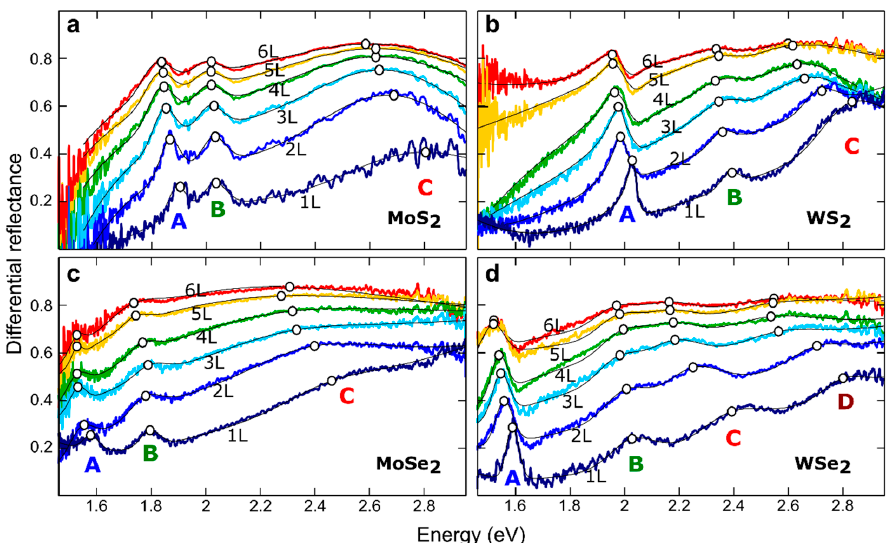
Figure 2. Differential reflectance spectra, measured as a function of the number of layers for ( a ) MoS 2 , ( b ) WS 2 , ( c ) MoSe 2 , and ( d ) WSe 2 . The spectra have been fitted to a sum of Lorentzian/Gaussian peaks (solid thin black lines), to determine the position of the different excitonic features (highlighted by white circles).